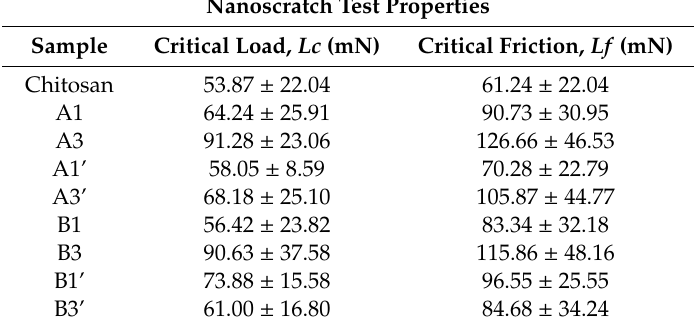
Table 4. Nanoscratch test properties of the chitosan and chitosan / Eudragit E 100 coatings (mean ± SD; n =